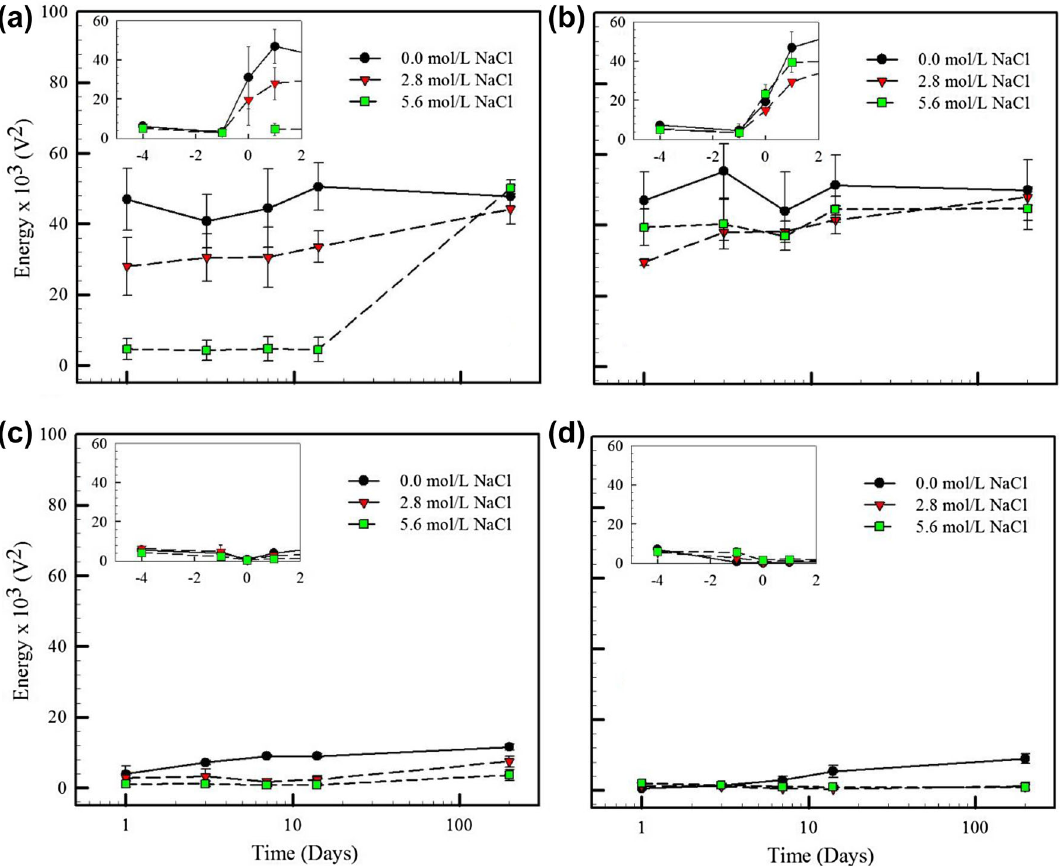
Fig. 8 Evolution of the energy over time of the specimen ultrasonic response (the error bars indicate ± one standard deviation), pastes a OPC, b 10SF, c 20FA, and d 40FA.